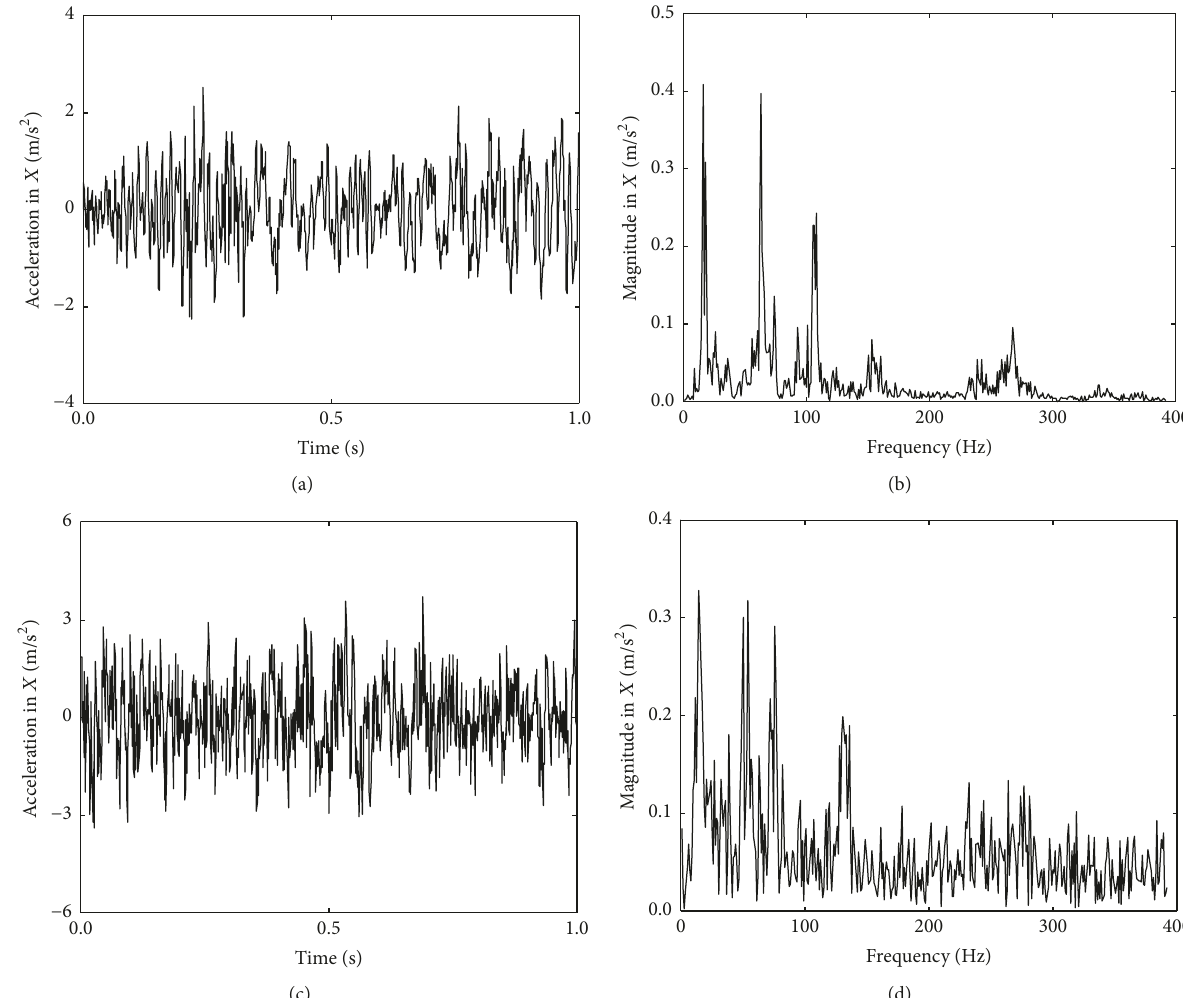
Figure 13: Acceleration responses of (a) simulated time history, (b) simulated spectrum, (c) measured time history, and (d) measured spectrum at main beam back tip in 𝑋